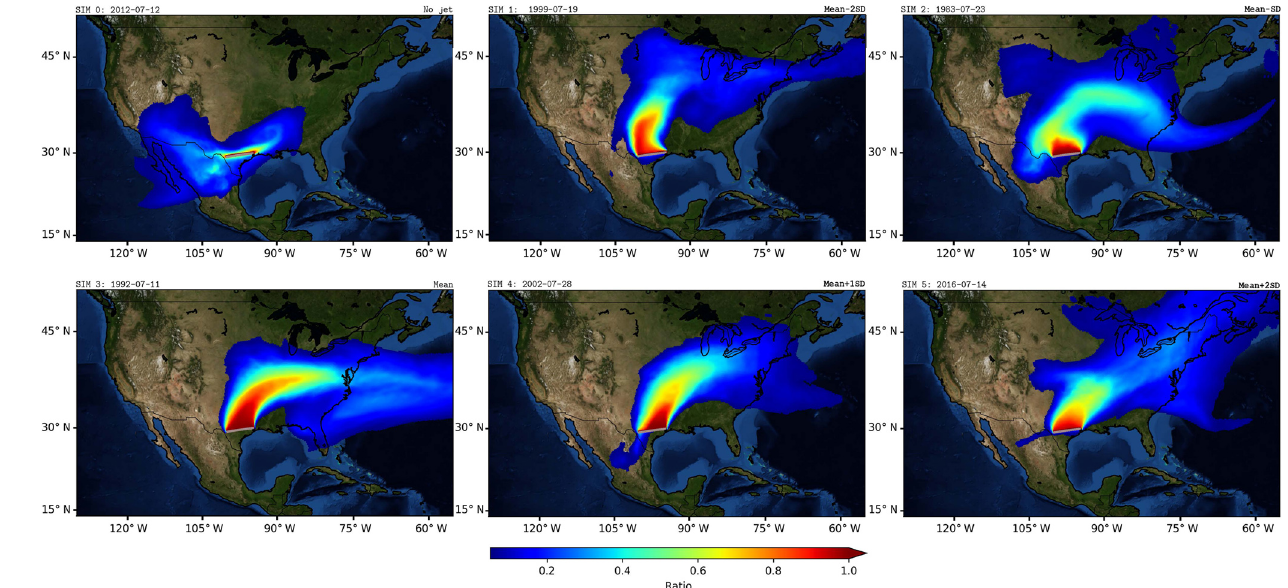
Figure 3. Ratio of tagged precipitable water transported by the GPLLJ to total for the six case studies analysed.